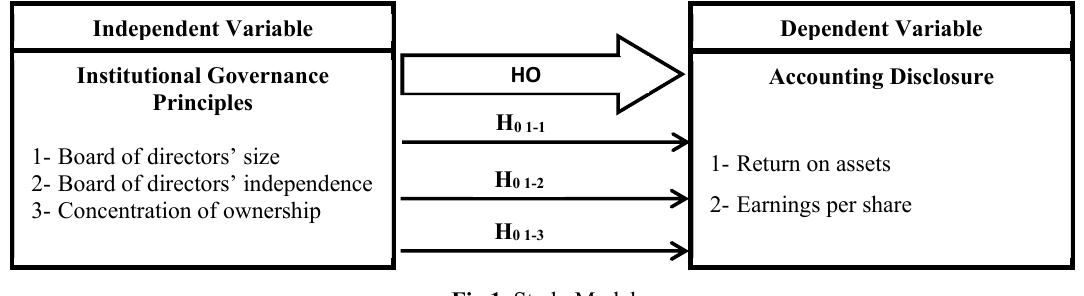
Fig 1. Study Model Source: Done by the researcher according to the previous references and studies, Al-Foley (2018), Shahwan & Habib (2020), and Samour & Dergham